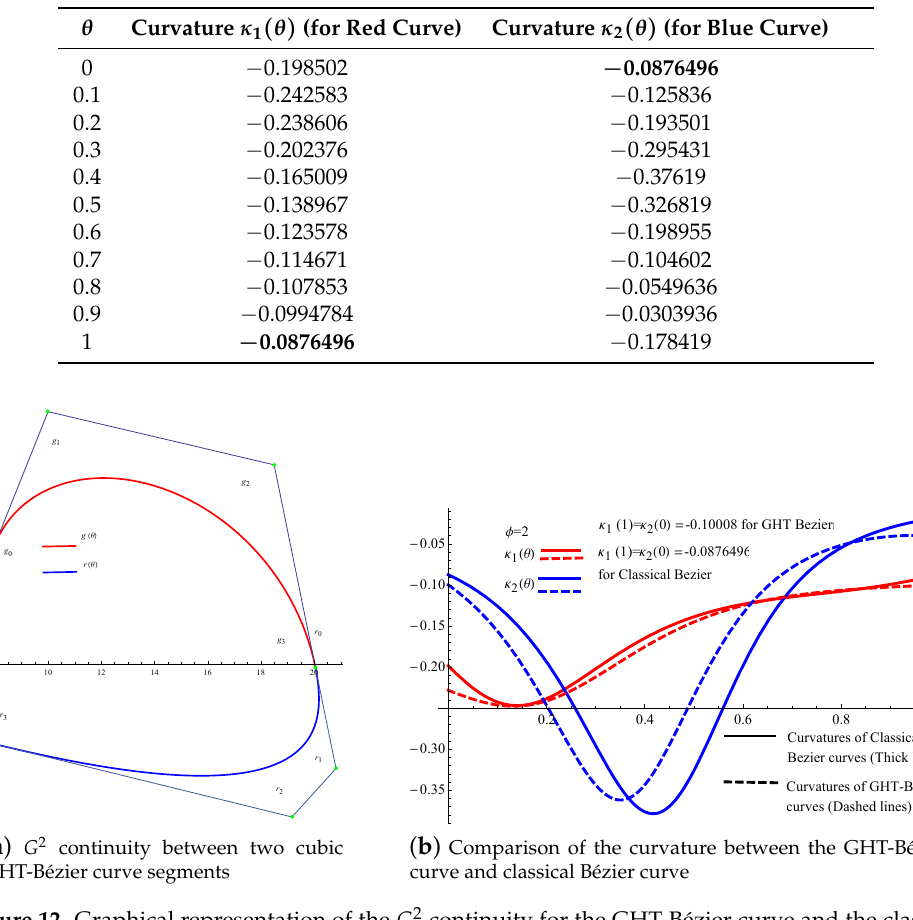
Table 1. Curvature values for G 2 continuity by the classical Bézier curve.